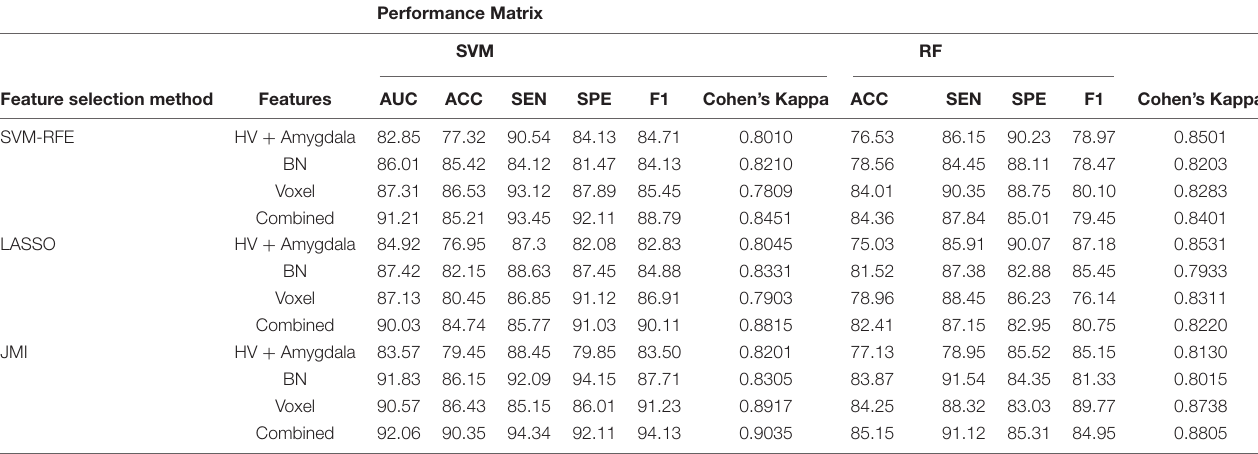
TABLE 4 | A 10-fold cross-validated binary classification performance for HC vs. MCI using SVM and RF classifiers. Performance Matrix